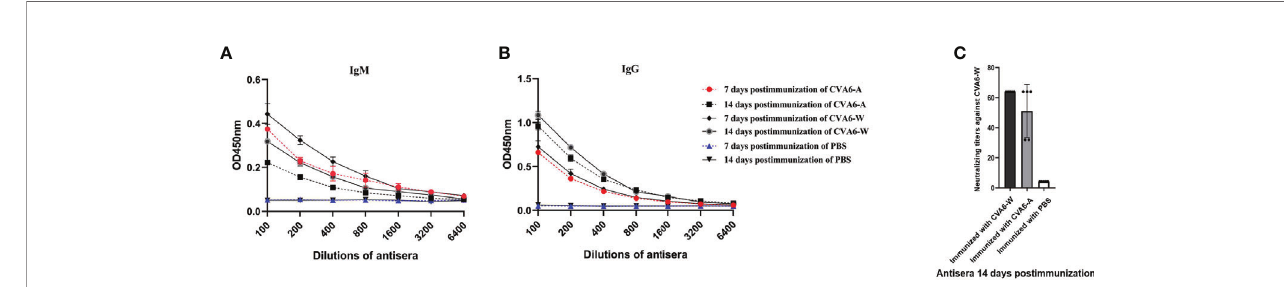
FIGURE 7 | Antibody responses of the 3-day-old mice immunized with inactivated coxsackievirus A6 (CVA6)-W, CVA6-A, or PBS. Three groups of three-day-old mice (5 per group) were immunized with inactivated CVA6-W, inactivated CVA6-A, or PBS. Their sera were collected 7 and 14 days later, respectively. The levels of IgM (A) and IgG (B) were detected by the enzyme-linked immunosorbent assay method. (C) All the sera collected 14 days post-immunization were used to detect the neutralization titer against CVA6-W by performing in vitro micro-neutralization test. The inactivated CVA6-A or CVA6-W induced the suckling mice to produce neutralizing antibodies